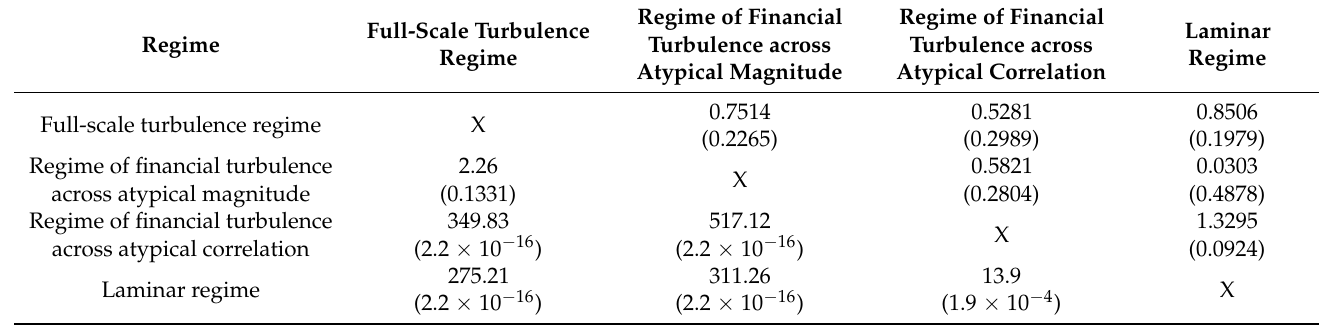
Table 7. Pair-wise consistency check of hidden regime features for the S&P 500 (the p -value is given in brackets).